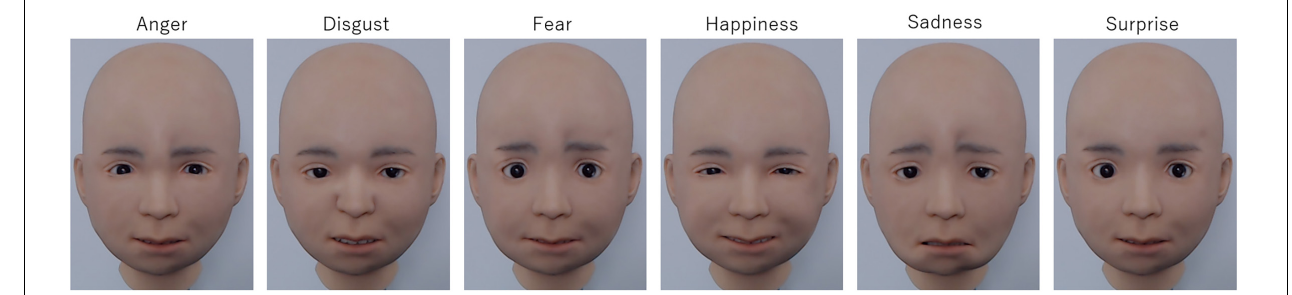
FIGURE 2 | Illustrations of the facial expressions of six basic emotions produced by the android Nikola.